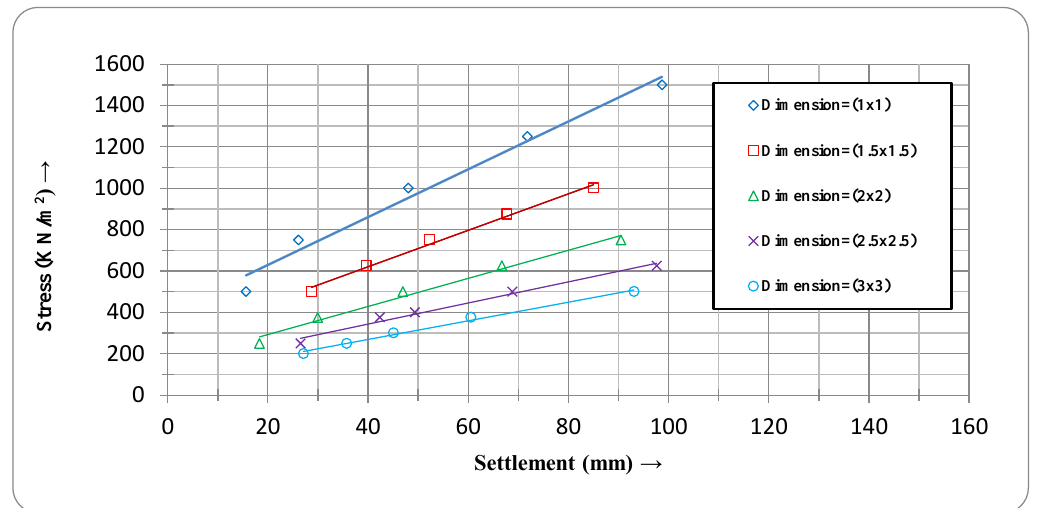
Fig. 18. Stress vs. Settlement graph for different footing size (spacing 2 m fixed between two adjacent footings). Regression analysis of Stress vs. Settlement (spacing 2 m fixed between two adjacent footings). Footing Dimension (m 2 ) Regression Equation Regression value, R2